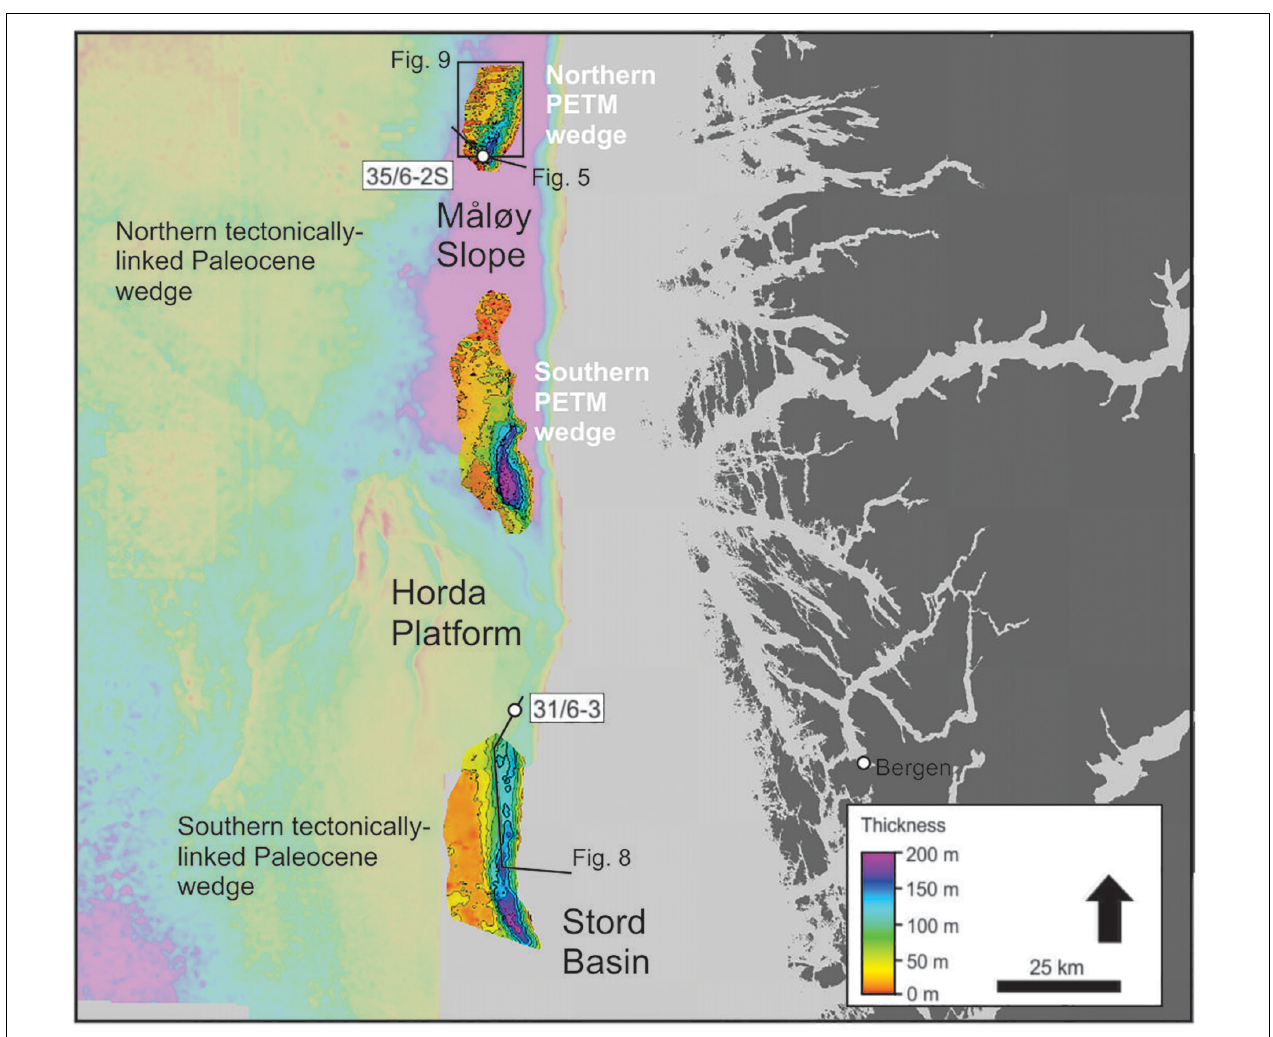
FIGURE 7 | Map showing the two (northern and southern) PETM depocenters on the Horda Platform and the Måløy Slope together with the northern and southern tectonically-linked depocenters on the Måløy Slope and in the Stord Basin (the former is made transparent for visualization purposes). Note the similarity in thickness between the PETM wedges and the southern tectonically-linked wedge. The PETM climatic wedges represent ∼ 150–200 kyr of deposition, whereas the tectonically linked wedges are believed to represents up to ∼ 3 Myr of